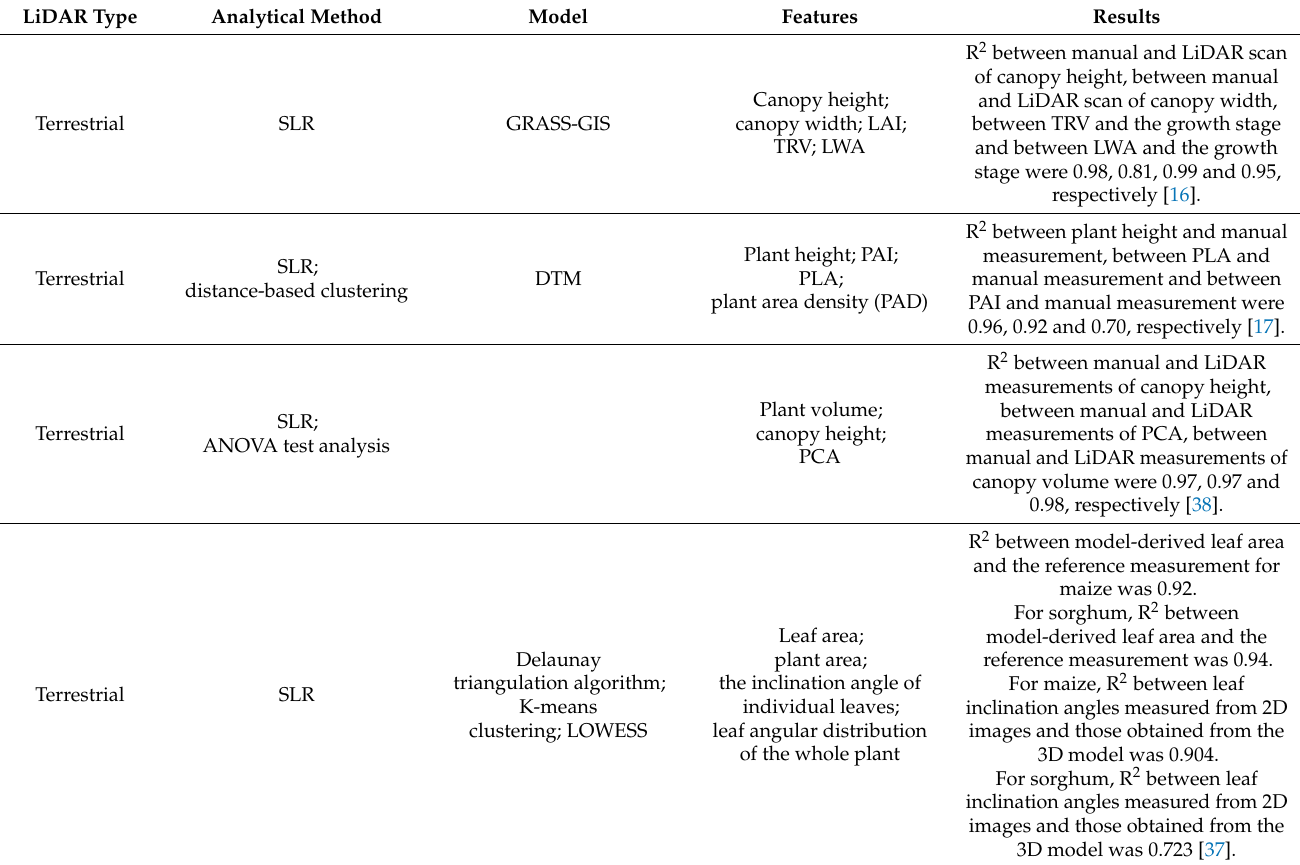
Table 4. Comparison of various aspects of LiDAR data in canopy phenological stages and pheno- type